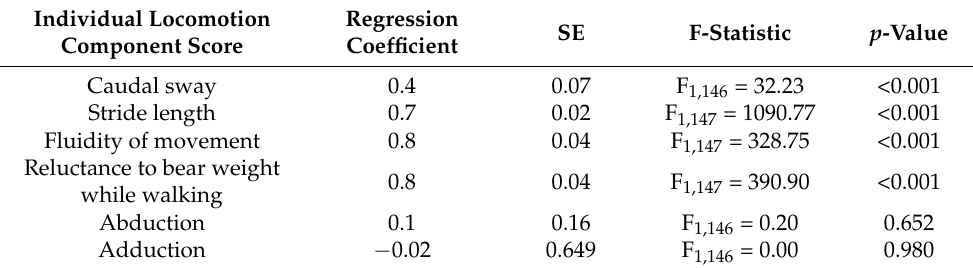
Table 3. Associations (regression coefficient and standard error; SE) between individual visual analogue scale (VAS) locomotion component scores and the VAS overall locomotion score in 51 gilts (n = 8 replicates), as a way of identifying a single locomotion component most associated with overall locomotory